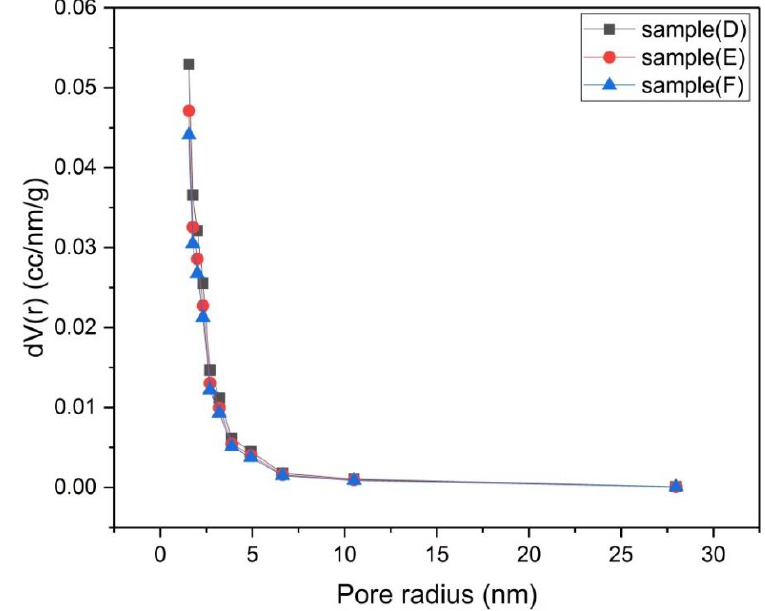
Figure 11. Mesopore size distribution by BJH method for samples (D), (E) and (F).